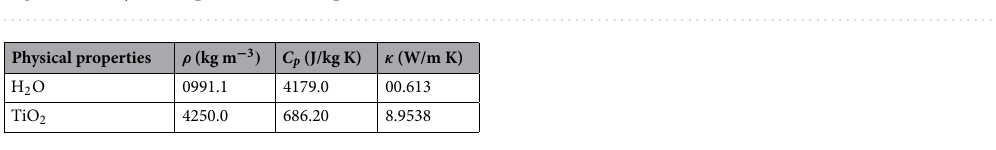
Figure 1. Physical representation of problem.